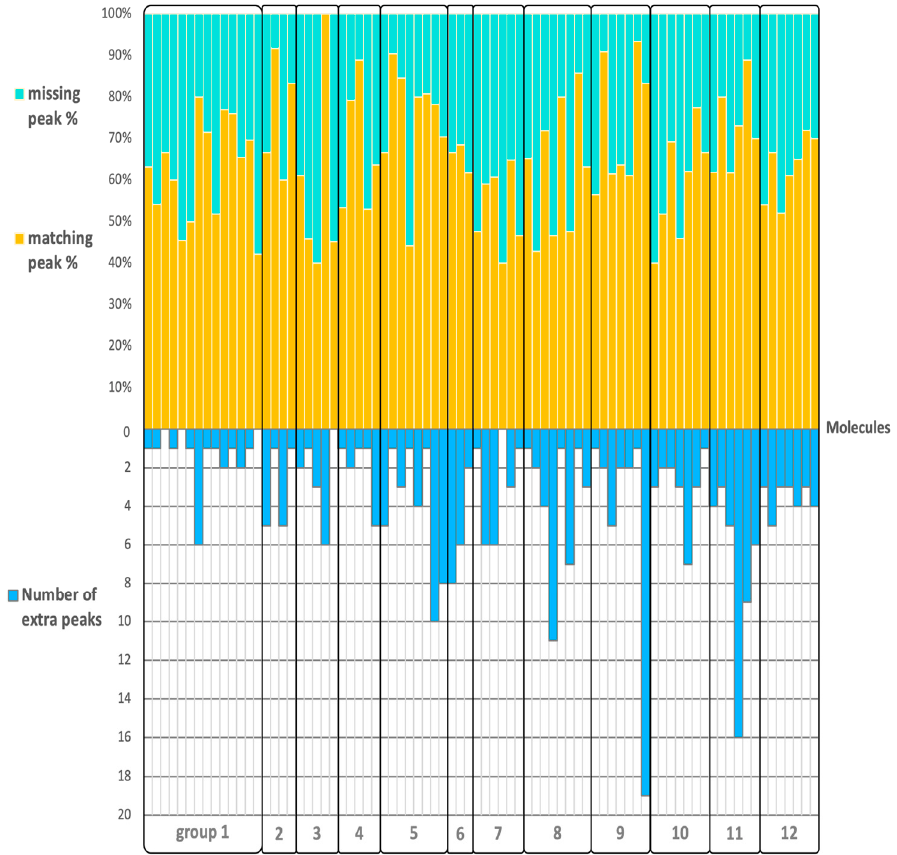
Figure 5. Detailing the accuracy of QCEIMS predictions of 80 purines and pyrimidines sorted by the 12 subclasses. Top : percentage of the number of matching and missing fragment ions. Bottom : number of additionally predicted fragment ions when comparing to NIST 17 experimental mass spectra.